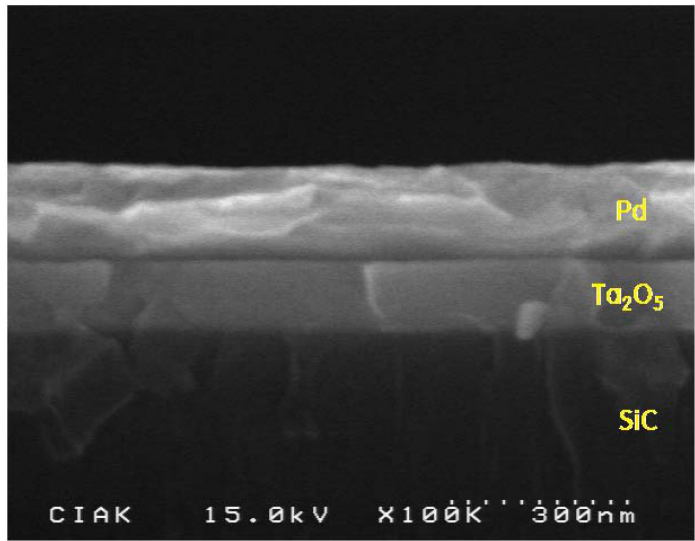
Figure 3. SEM image of the